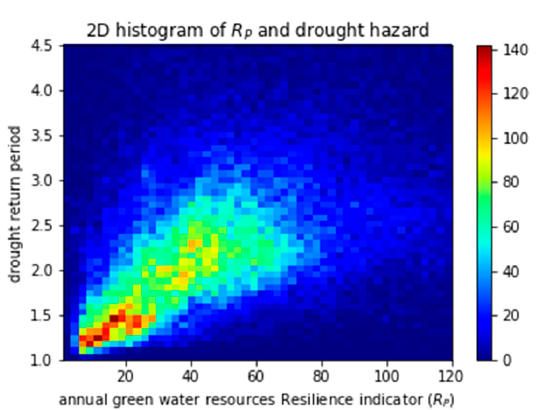
Figure 2. 2D histogram of annual green water resources Resilience indicator ( R P ) and return periods of drought computed using observed data since 1901.